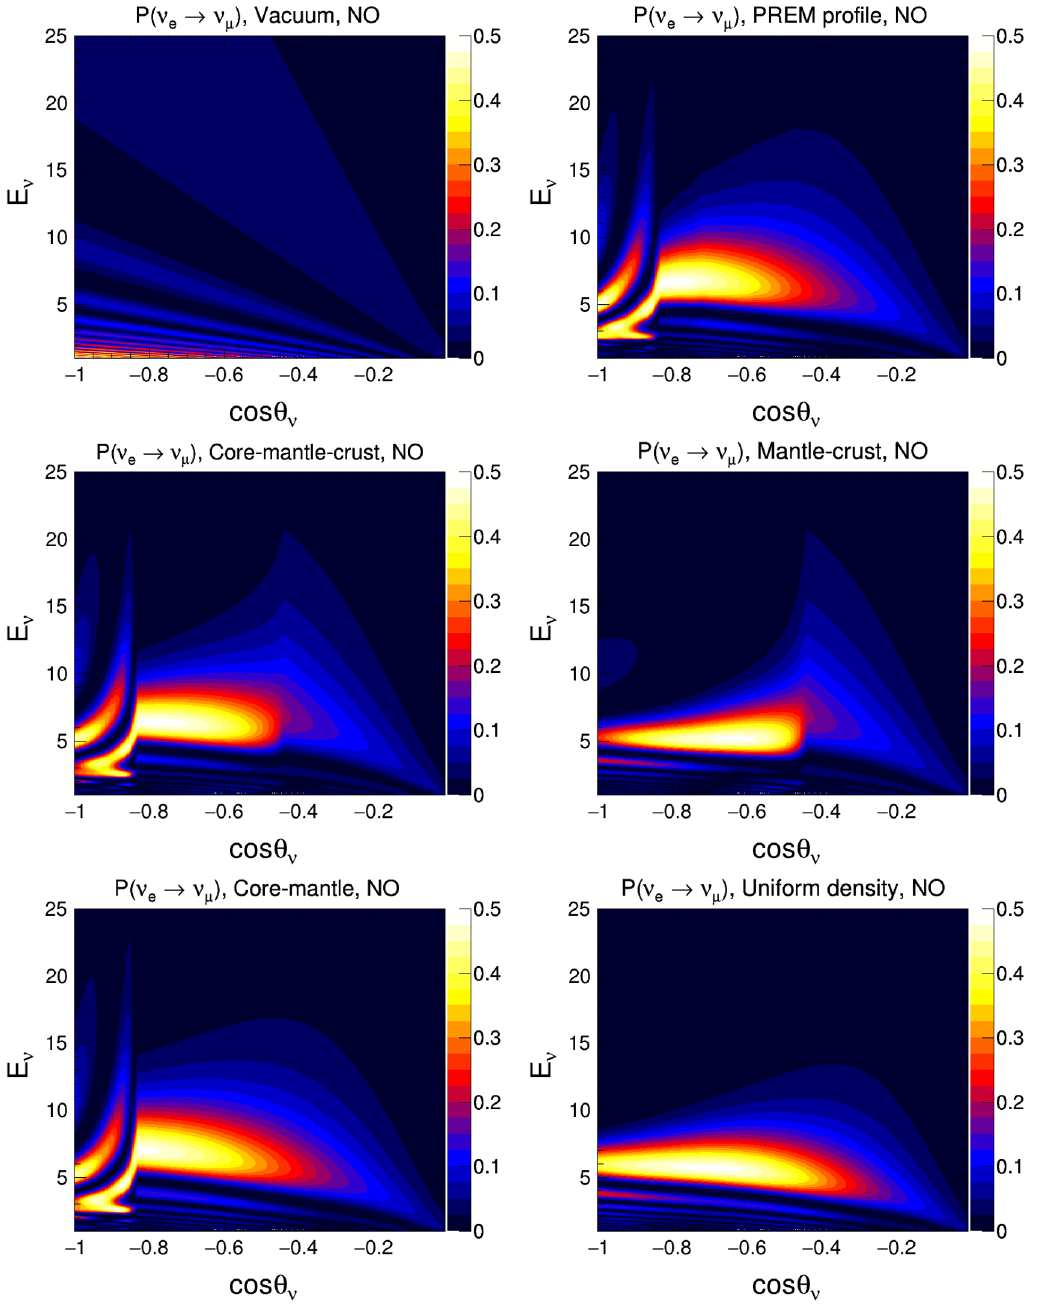
Figure 3 . P ( ν e → ν µ ) oscillograms considering various density profiles of Earth. We take the three-flavor oscillation parameters from table 2. We assume NO and sin 2 θ